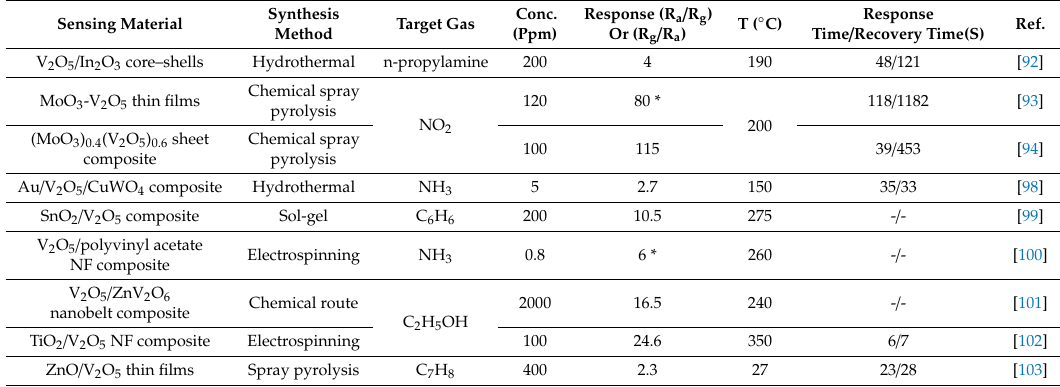
Table 3. Gas sensing properties of V 2 O 5 -based composite gas